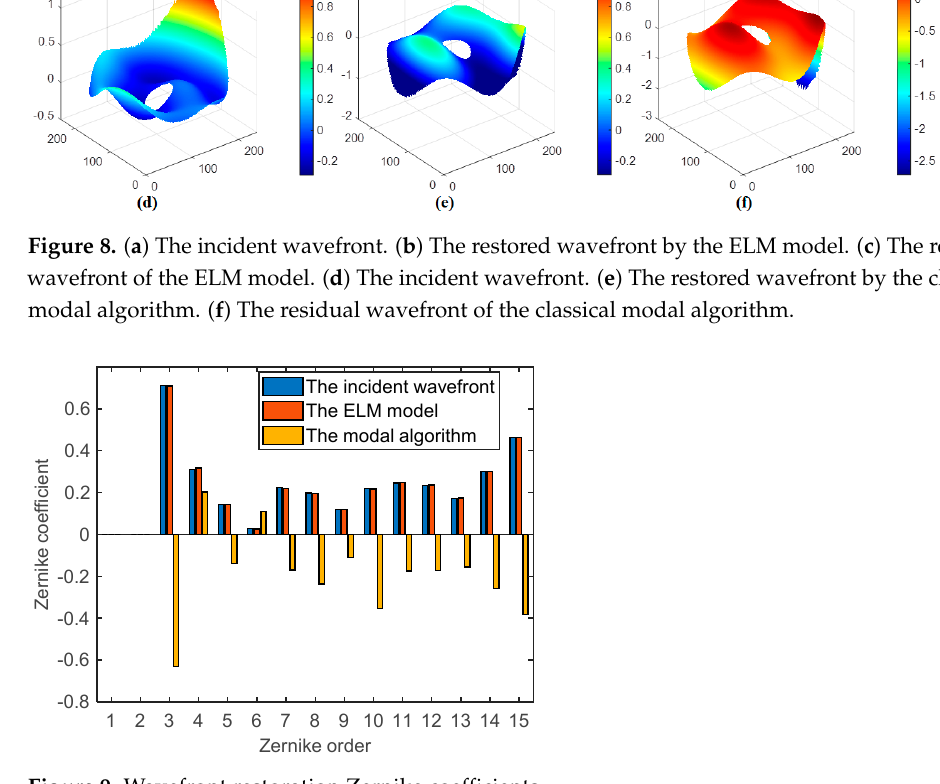
Figure 9. Wavefront restoration Zernike coefficients.